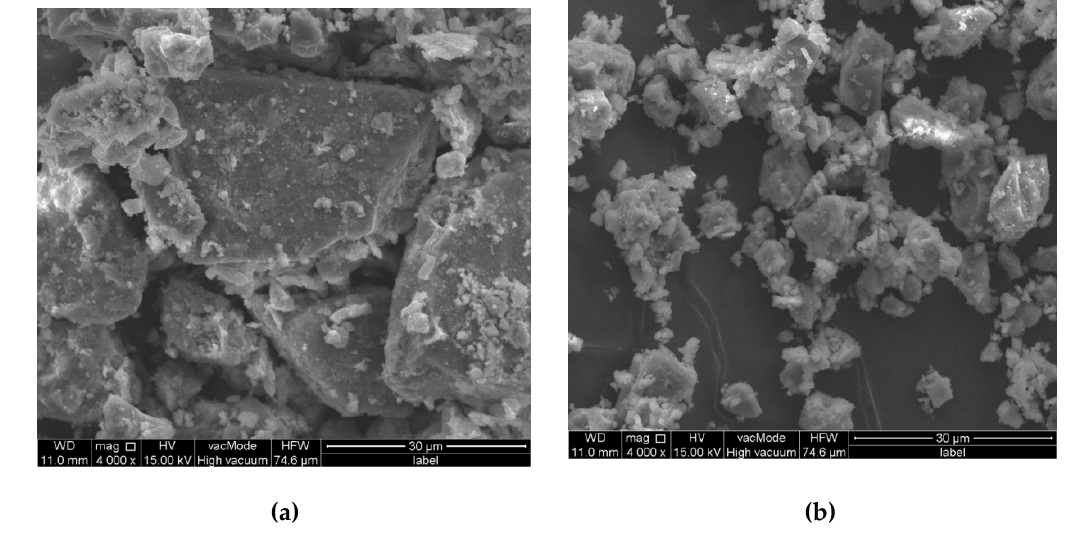
Figure 4. Scanning electron microscopy images of ( a ) brick debris dust and ( b ) lime filler.